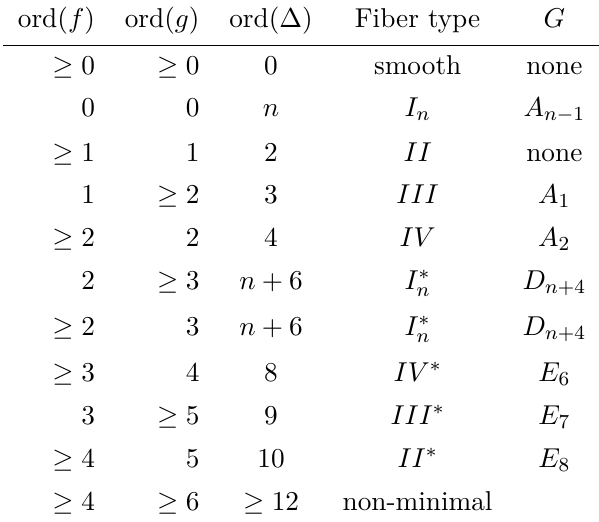
Table 1 . Kodaira’s classification of singularities of an elliptic